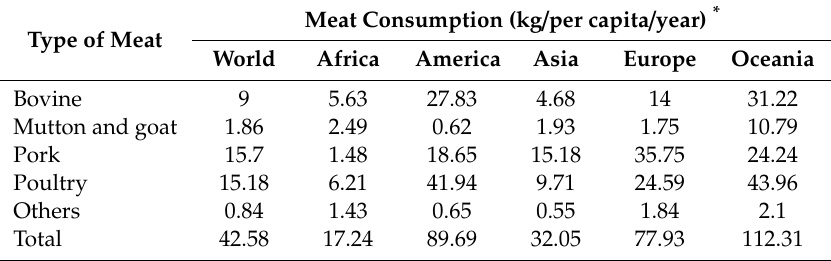
Table 1. Meat consumption worldwide and by continent in